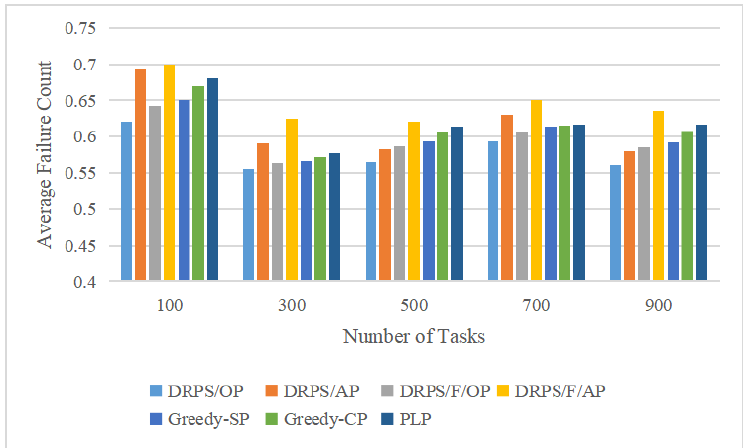
Figure 7. Results of the AFC.